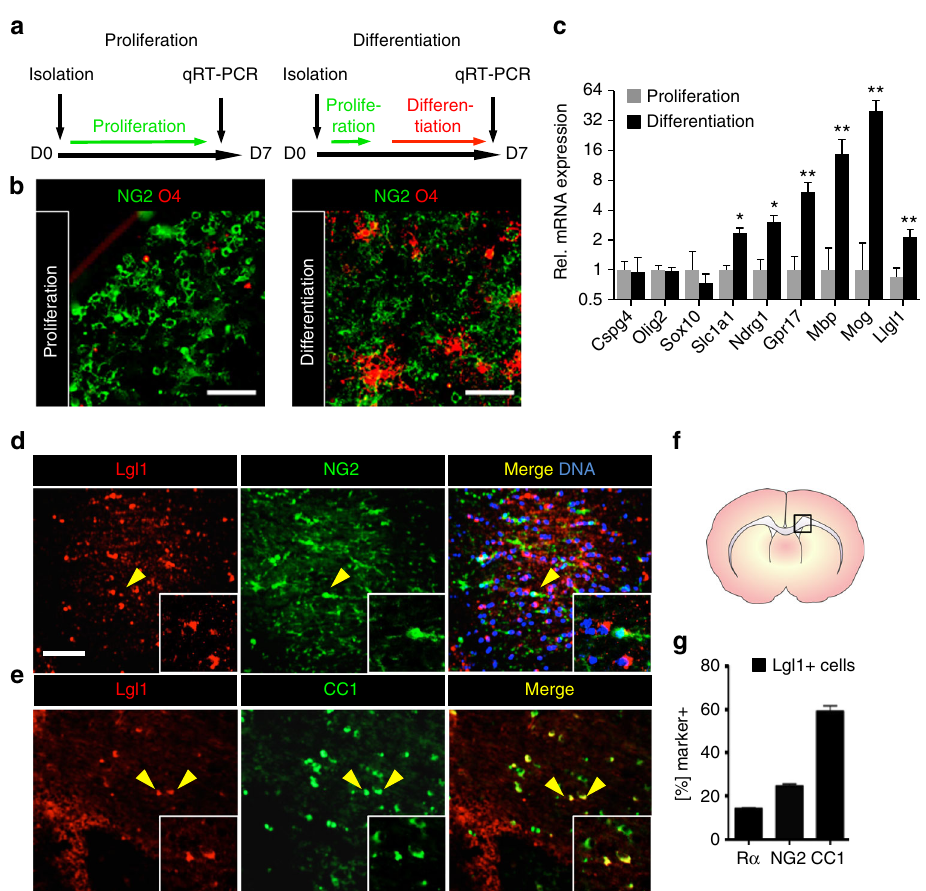
Fig. 1 Lgl1 is expressed in oligodendrocyte progenitor cells (OPC) and its expression increases with differentiation into oligodendrocytes. a Scheme of OPC treatment before qRT-PCR. b Immuno fl uorescence for OPC marker NG2 and oligodendrocyte differentiation marker O4 of corpus callosum-derived OPC under proliferating or differentiating conditions. Differentiation increases O4-positive cell frequency. Scale bar = 100 µ m. c Graph representing mRNA expression level changes with differentiation. qRT-PCR results are displayed on a log 2 scale and normalized to proliferative conditions. Data represented as mean ± s.e.m. of fi ve independent experiments ( n = 5, * p < 0.05, ** p < 0.01, Mann – Whitney test). d , e Co-immunostaining of P35 wildtype mouse corpus callosum for Lgl1 and OPC marker NG2 (top panels) or differentiation marker CC1 (bottom panels). Insets are high magni fi cation panels of Lgl1 positive cells (yellow arrows). Scale bar: 100 μ m. f Schematic of coronal section of a P60 mouse showing the corpus callosum where cells were counted. g Quanti fi cation of PDGFR α -positive, NG2-positive, and CC1-positive cells per total Lgl1-positive cells. 14% were PDGFR α -positive, 22% were NG2-positive, and 59% were CC1-positive. Data are represented as mean ± s.e.m. of four independent